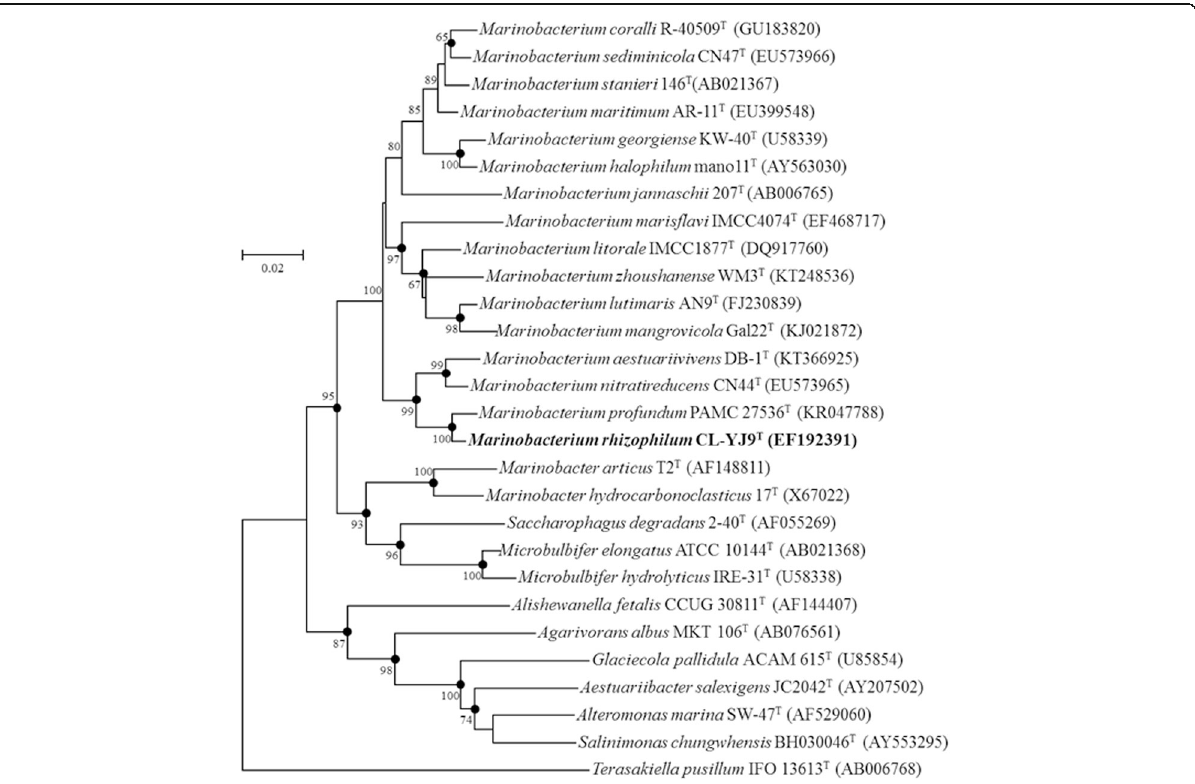
Fig. 1 Neighbour-joining phylogenetic tree, based on 16S rRNA gene sequences, showing the relationships between strain CL-YJ9 T , members of the genus Marinobacterium and other related genera. Bootstrap percentages >60% (based on 1000 resamplings) are shown below or above the corresponding branches. Solid circles indicate that the corresponding nodes are also recovered in the maximum-likelihood and maximum-parsimony trees. Terasakiella pusillum IFO 13613 T (AB006768) was used as an outgroup. Bar, 0.02 nucleotide substitutions per